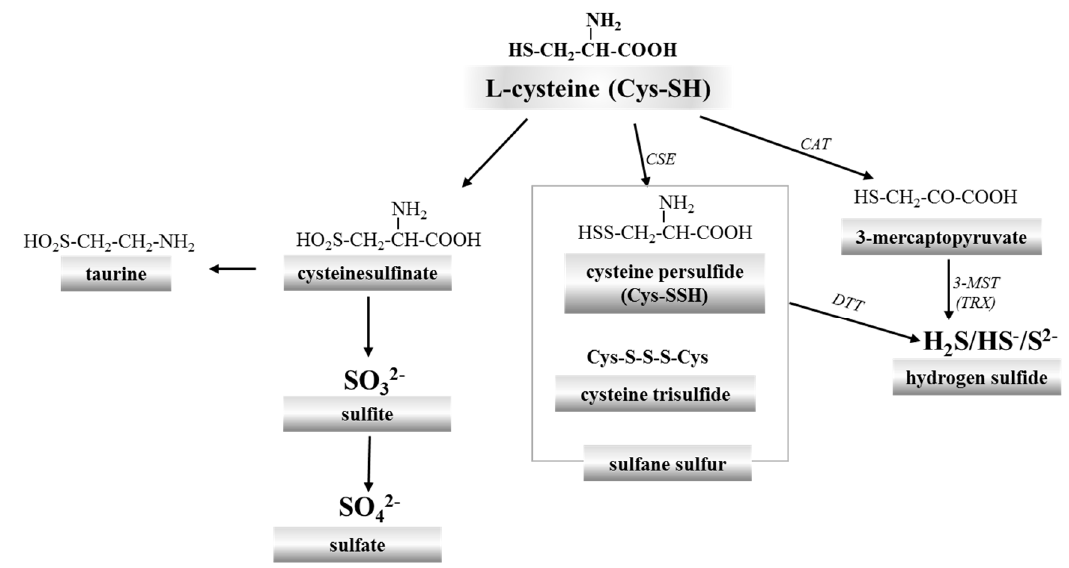
Figure 1. Two L -cysteine transformation pathways: the aerobic path leads to taurine and sulfate, while the anaerobic route to sulfane sulfur-containing compounds and hydrogen sulfide. CSE: cystathionine γ -lyase; CAT: cysteine aminotransferase; 3-MST: 3-mercaptopyruvate sulfurtransferase; TRX: thioredoxin; DTT: dithiothreitol.